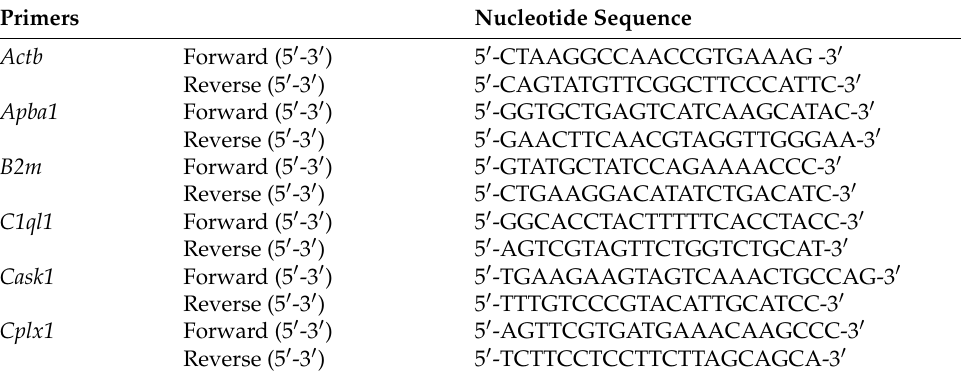
Table 2. Primers used for